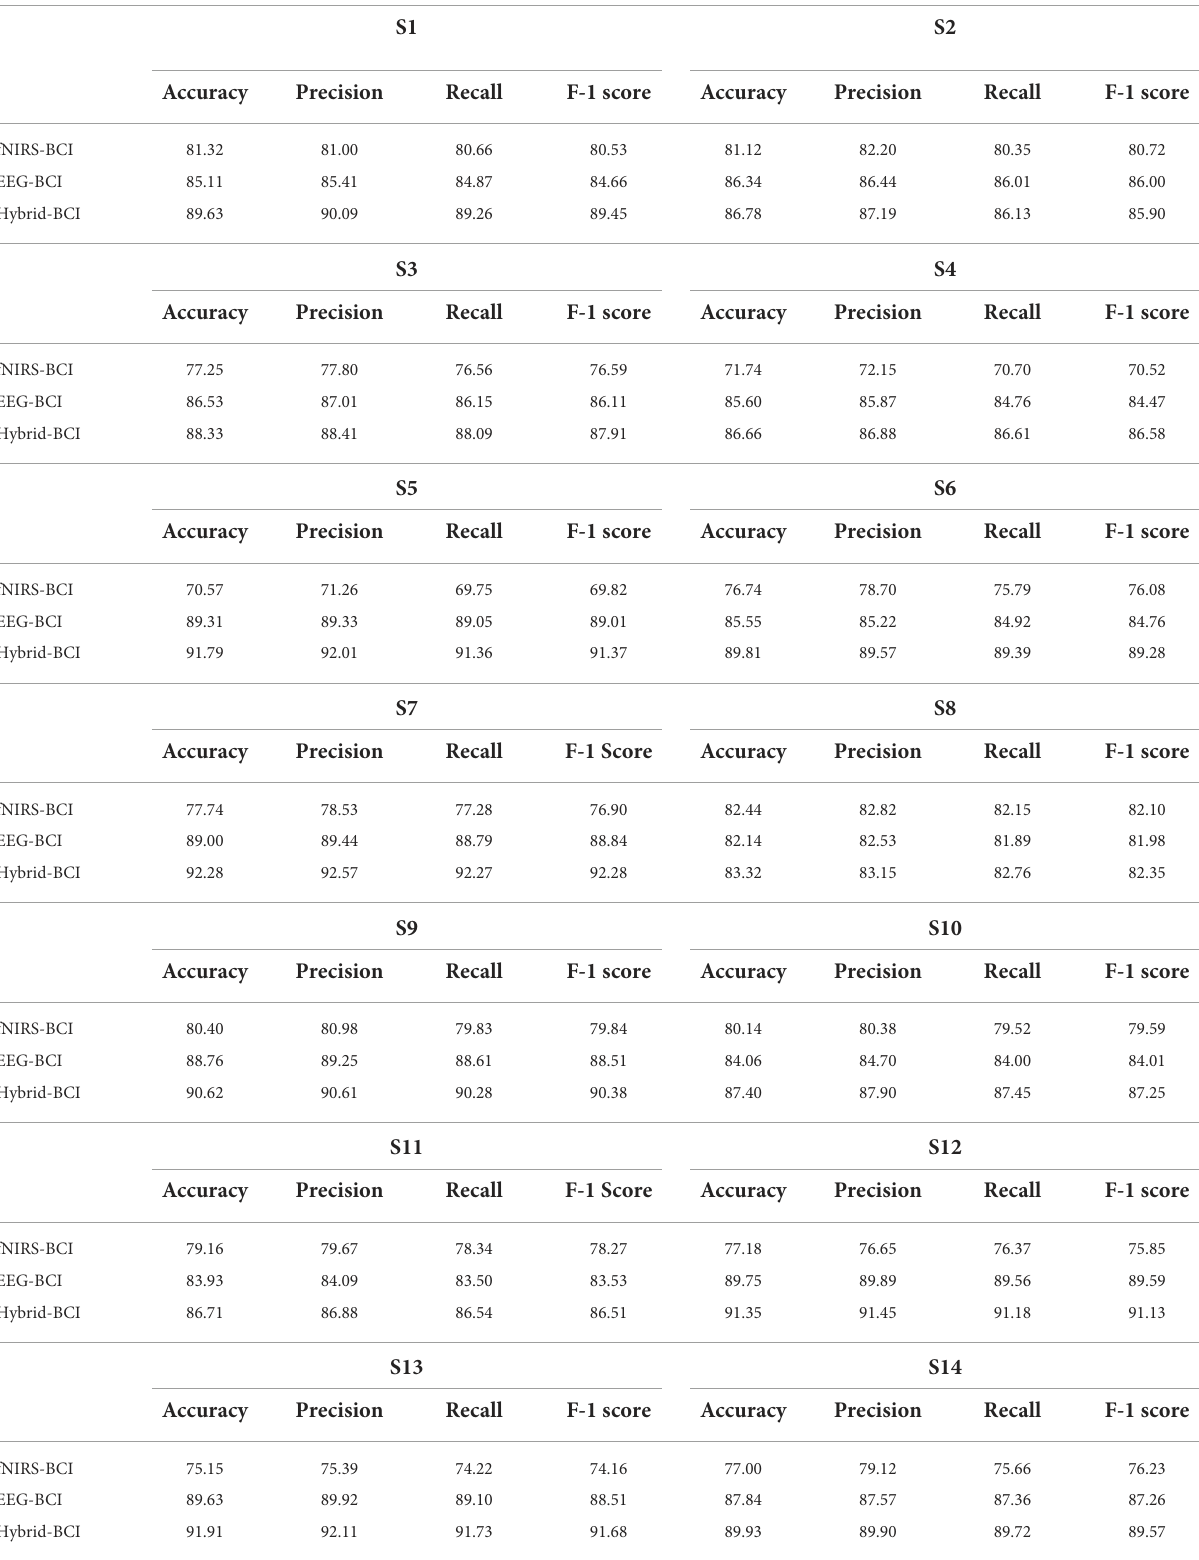
TABLE 1 Performance evaluation metrices of fNIRS-BCI, EEG-BCI, and hybrid EEG-fNIRS-BCI. S1